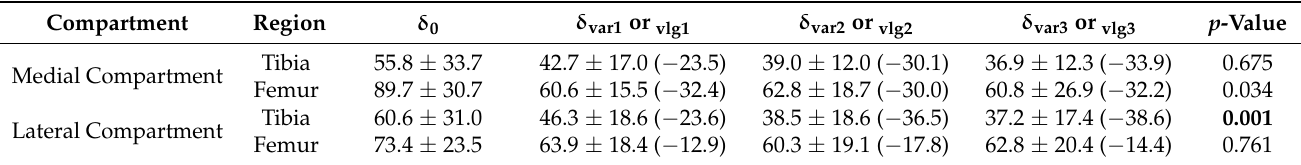
Table 3. Mean absolute T1 ρ relaxation times of femoral and tibial articular cartilage in response to loading. Mean ± standard deviation (ms) (mean percentage change versus δ 0 (%)). Statistical analysis was performed using Friedman’s test with statistically significant findings highlighted in bold type . Please refer to Table 2 for additional details on table organization.